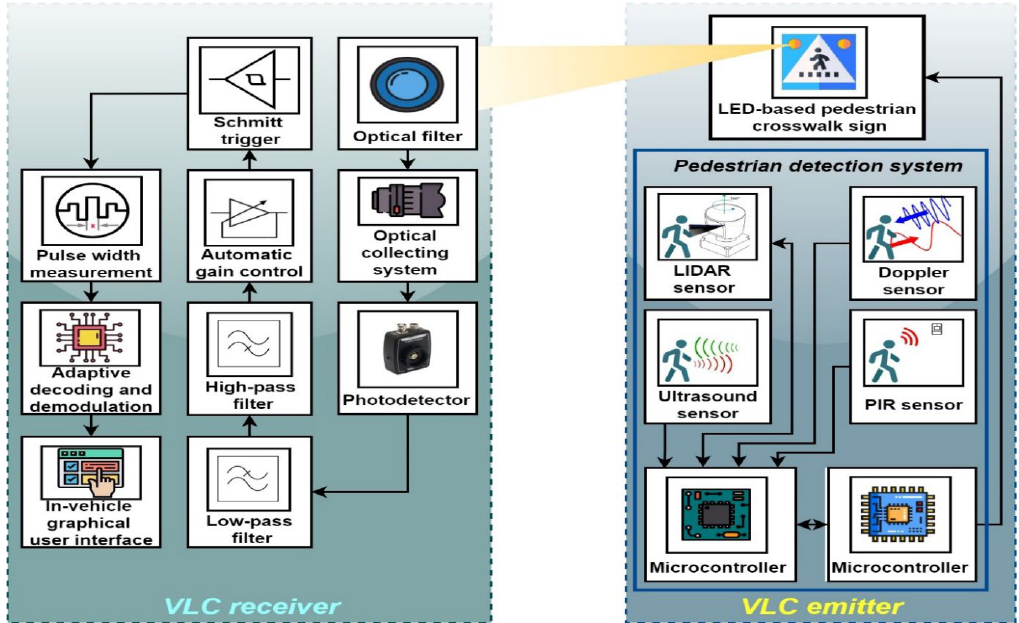
Figure 5. Schematic of the proposed system showing the interconnectivity between the VLC component and the pedestrian detection and localization component.